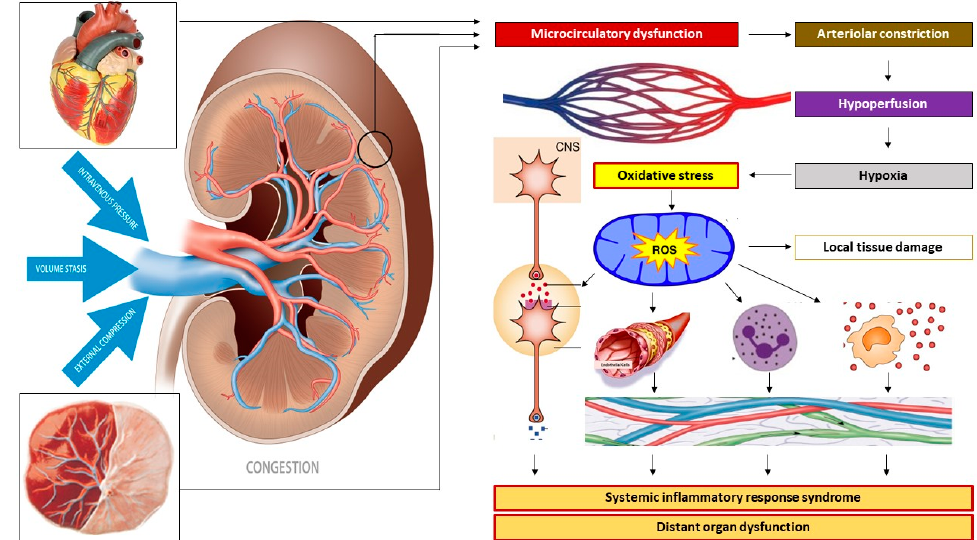
Figure 4. Mechanisms of venous congestion at the level of the kidney. Venous congestion can result from venous vascular hypertonia with subsequent venous hypertension, from volume stasis arising from (sub-)obstructed outflow, and / or from external compression. At the level of the kidneys, this congestion induces a retrograde dysfunction of the peritubular and glomerular capillaries. Reflex arteriolar constriction and activation of the renin–angiotensin–aldosterone system prevents further microcirculatory deterioration at the cost of reduced organ perfusion and subsequent parenchymal hypoxia. An oxidative stress response induces immunological, neurological, and metabolic protection mechanisms by activating the autonomic nervous system and the intravascular distribution of cytokines, endocrines, and vasoactive mediators, causing endothelial activation and a generalized state of inflammation. In non-pregnant individuals, this sequence of events unfolds in the kidneys as part of the pathophysiology of renocardial syndrome but can also occur in other internal organs as in cardiohepatic or hepatorenal syndromes. In pregnancy, this mechanism may unfold in the uterus and placenta as well as in internal organs. In this picture, the kidney may serve as a proxy for other maternal organs, such as uterus-placenta, heart,